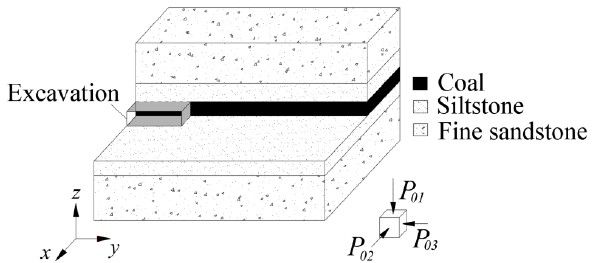
Figure 1. The three ‐ dimensional numerical model. Figure 1. The three-dimensional numerical model. Table 1. The parameters used for coal and rock. Table 1. The parameters used for coal and rock.